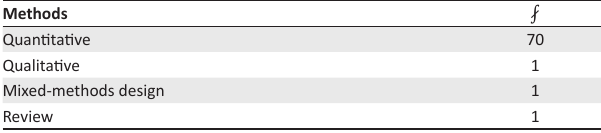
TABLE 2: Method use in sample frequency.